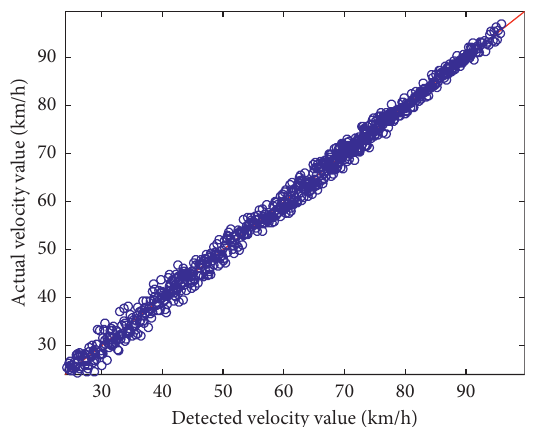
Figure 3: Actual velocity value and the detected velocity value.